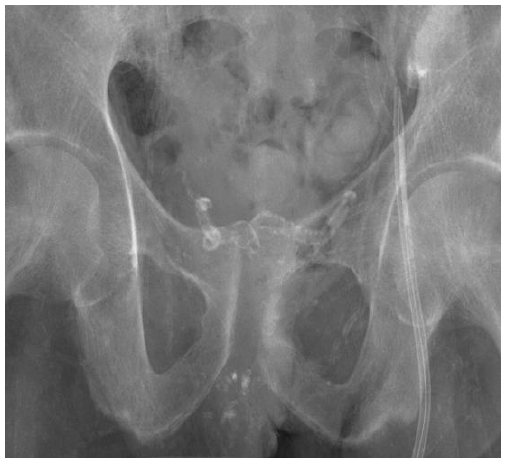
FIGURE 3. Plain film showing calcification of ejaculatory duct and calciphylaxis.